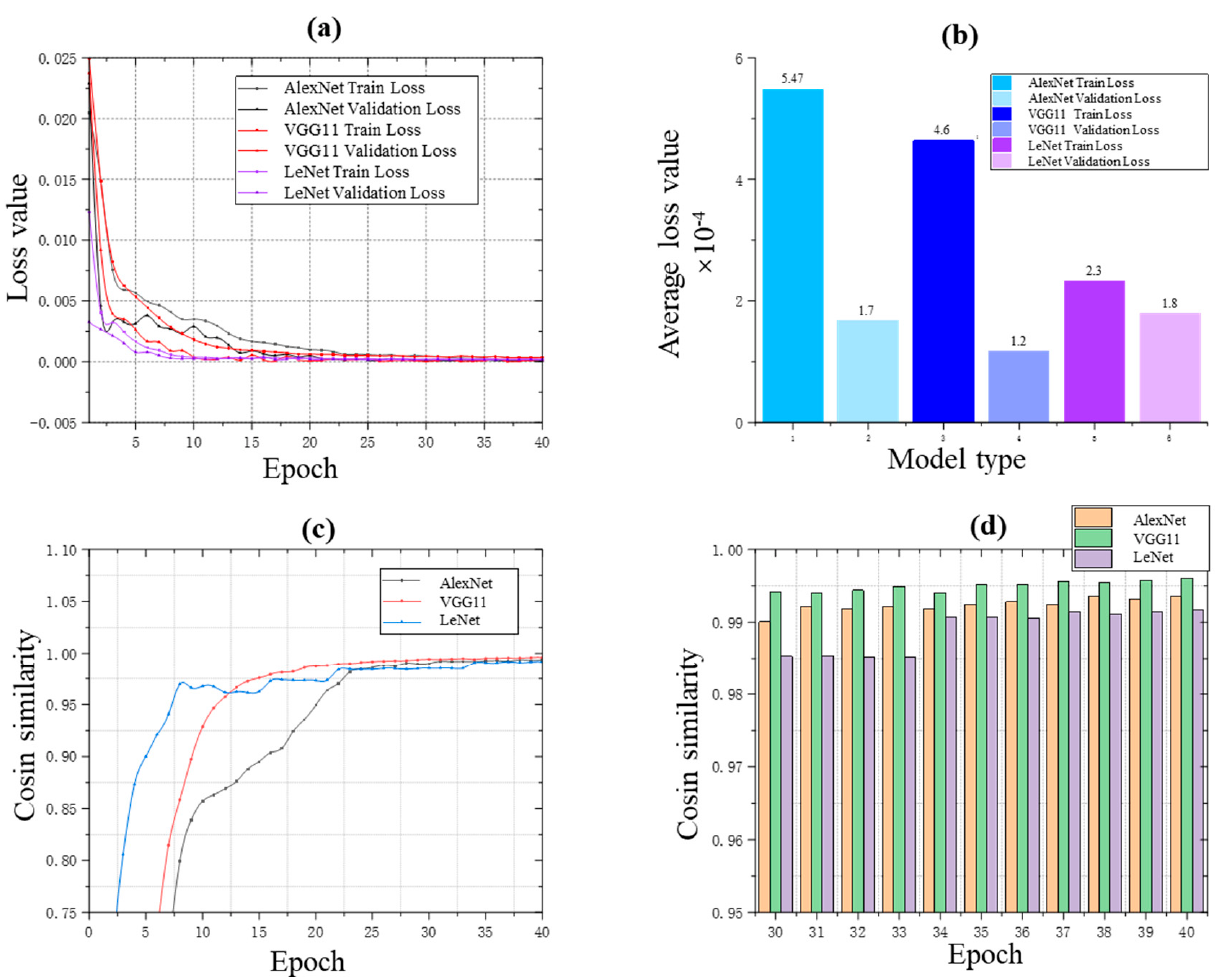
Figure 11. ( a , b ) show the loss curves, ( c , d ) show the cosine similarity of model training. In ( a , b ), the comparison of loss values, the VGG11 model is better than AlexNet model, while the training loss of LeNet is smaller than that of VGG11 model, but the validation loss of VGG11 model is smaller. A smaller loss value means better network performance. Although these 3 models perform well, the VGG11 model has better and more stable performance. ( c ) shows the change of cosine similarity during model training. VGG11 network shows the best performance of the 3 models. Through the histogram ( d ) we can see the training change law in the process of 30–40